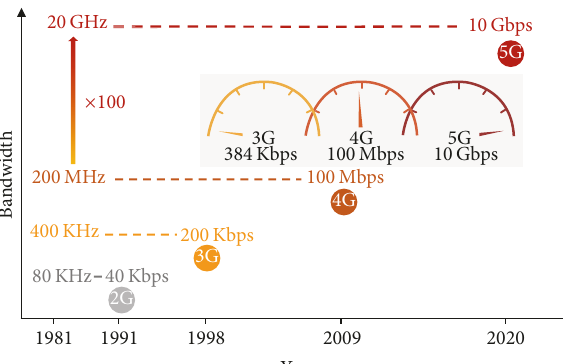
Figure 2: Plane wave incident on a linear